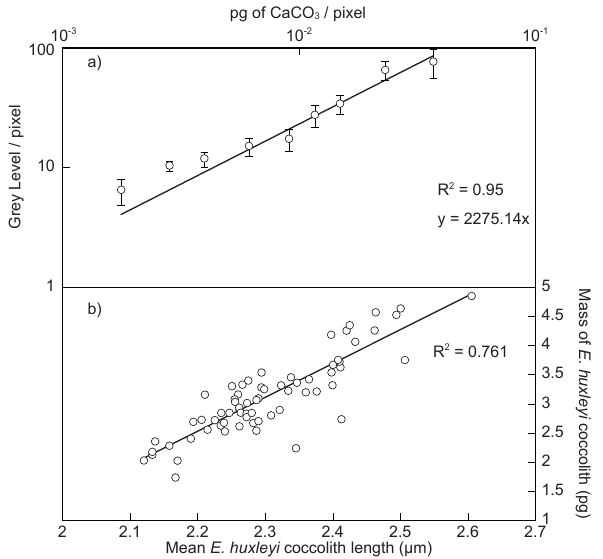
Fig. 2. Method calibration and validation. (a) Relation between the mass of calcite and the average GL values. The x and y axes are both on a logarithmic scale. The regression line (black) is forced to the axis origin. The vertical error bars give the 2 σ standard devi- ation (b) E. huxleyi coccolith length versus mass, with black line indicating the linear